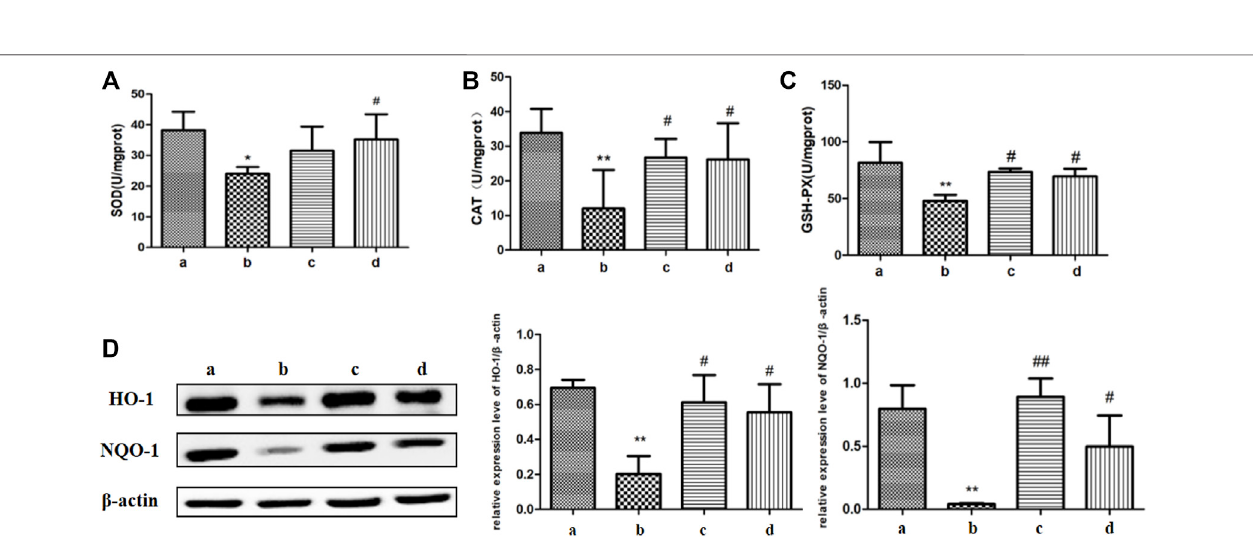
FIGURE 4 | Effects of ICA on colonic oxidative stress in aging rats. The regulation of ICA on antioxidant enzymes (A) SOD, (B) CAT, and (C) GSH-Px in the colon of agingratsweredetectedbybiochemicalkits. (D) TheexpressionsofHO-1andNQO-1inthecolonofagingratsweredetected byWesternblot.a:Adultgroup,b:Aging group, c: ICA-L group, d: ICA-H group. * p < 0.05 vs. Adult group. ** p < 0.01 vs. Adult group. # p < 0.05 vs. Aging group. ## p < 0.01 vs. Aging group, n = 5-8.